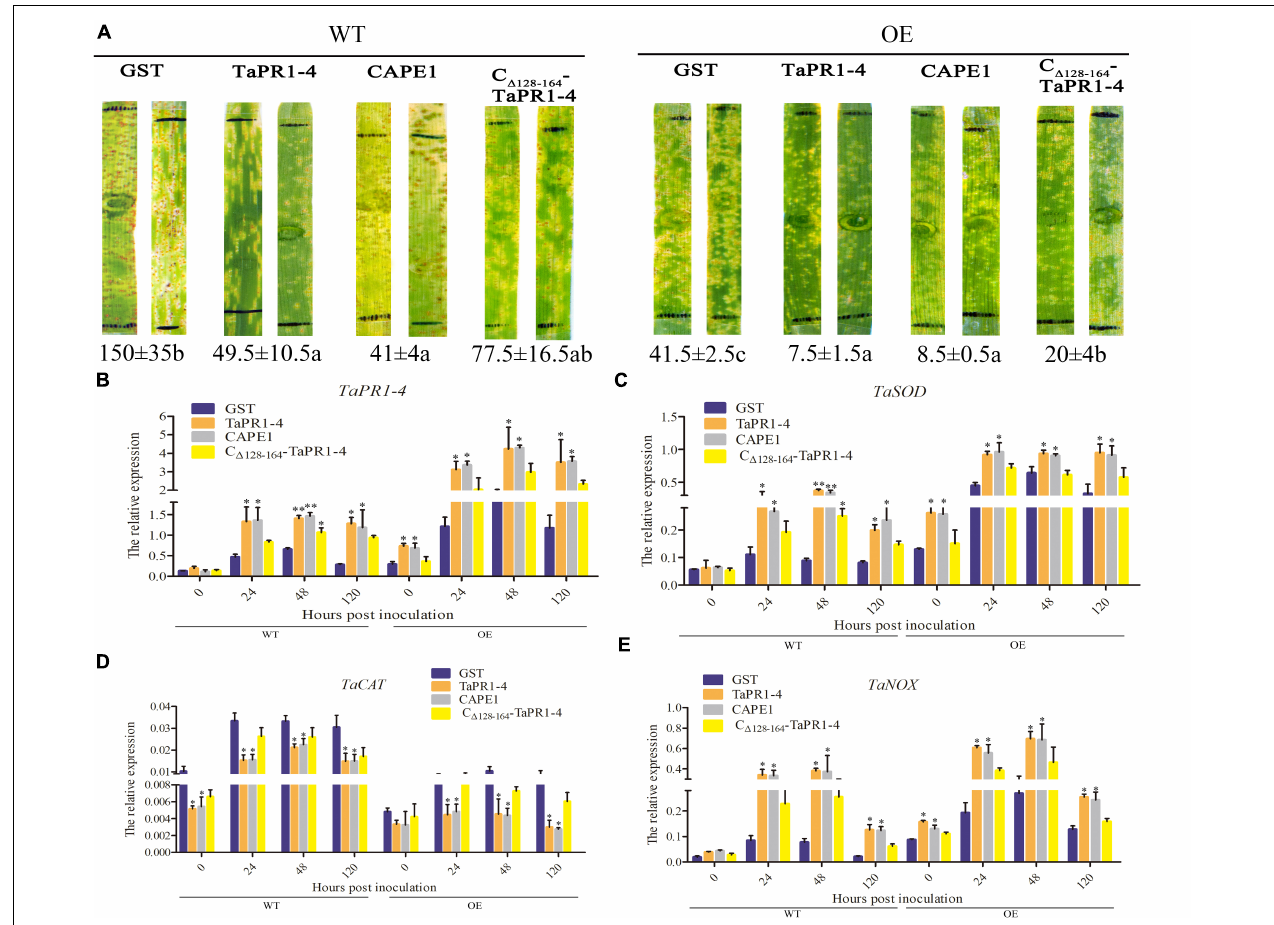
FIGURE 5 | CAPE1 mediates TaTLP1-induced defense responses. (A) GST, TaPR1-4, CAPE1, and C (cid:49) 128 − 164 -TaPR1-4 (0.1 mg/ml) were infiltrated into the first and second leaves of TaTLP1-OE and WT lines (WT, JW1). Black lines indicate the infiltration zones. The numbers of urediniospores were quantified using Image J software. (B–E) Relative expression is expressed as fold change relative to mock-inoculated plants at 0 hpi. The y-axis indicates the amount of resistance-related genes transcript normalized to the GAPDH gene. The x-axis indicates sampling time. TaTLP1-OE and WT lines infiltration with GST protein was standardized as 1. Values are means ± SEM of three independent biological replicates. Significant differences were assessed using one-way analysis of variance (ANOVA) and Duncan’s multiple range test (DMRT) (* p < 0.05, ** p <